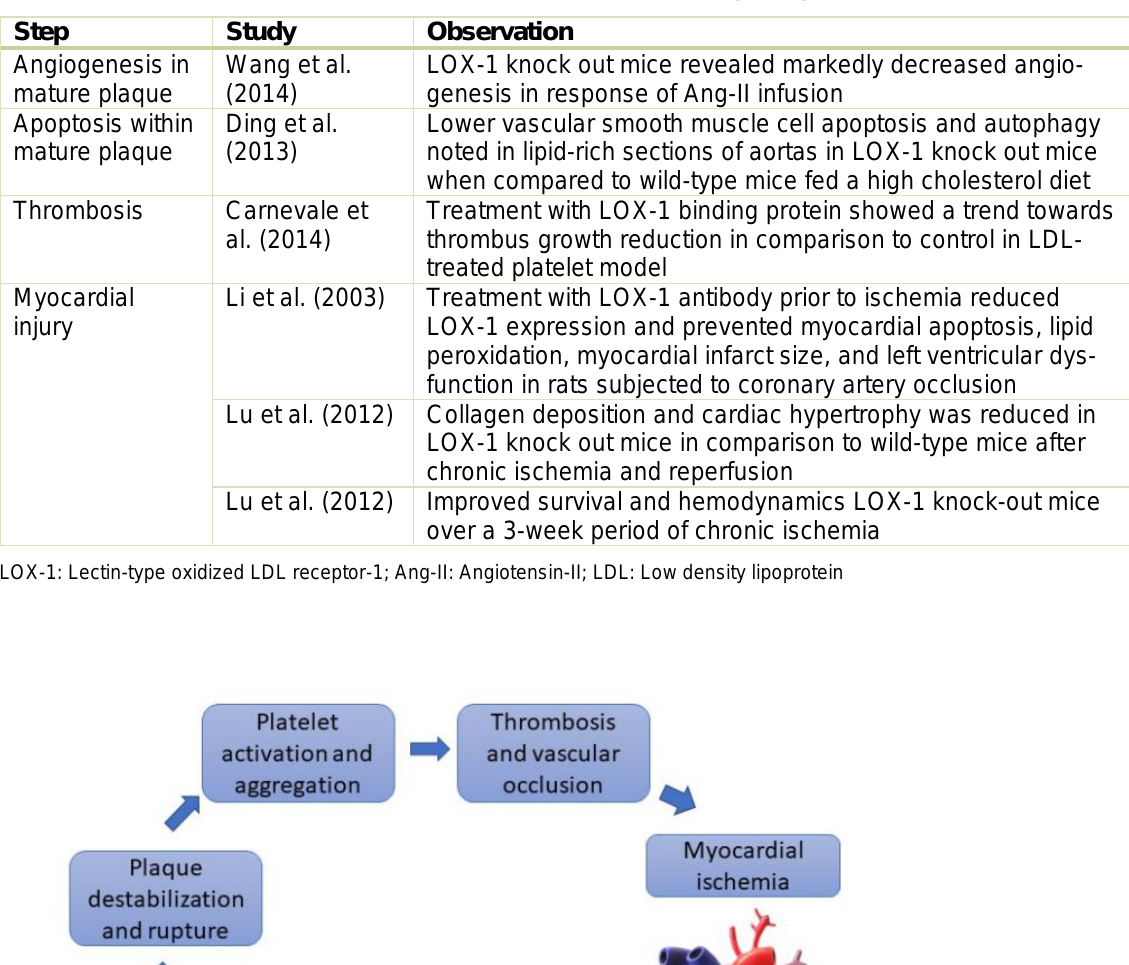
Table 2: Effect of LOX-1 inhibition on the ischemic cascade leading to myocardial infarction